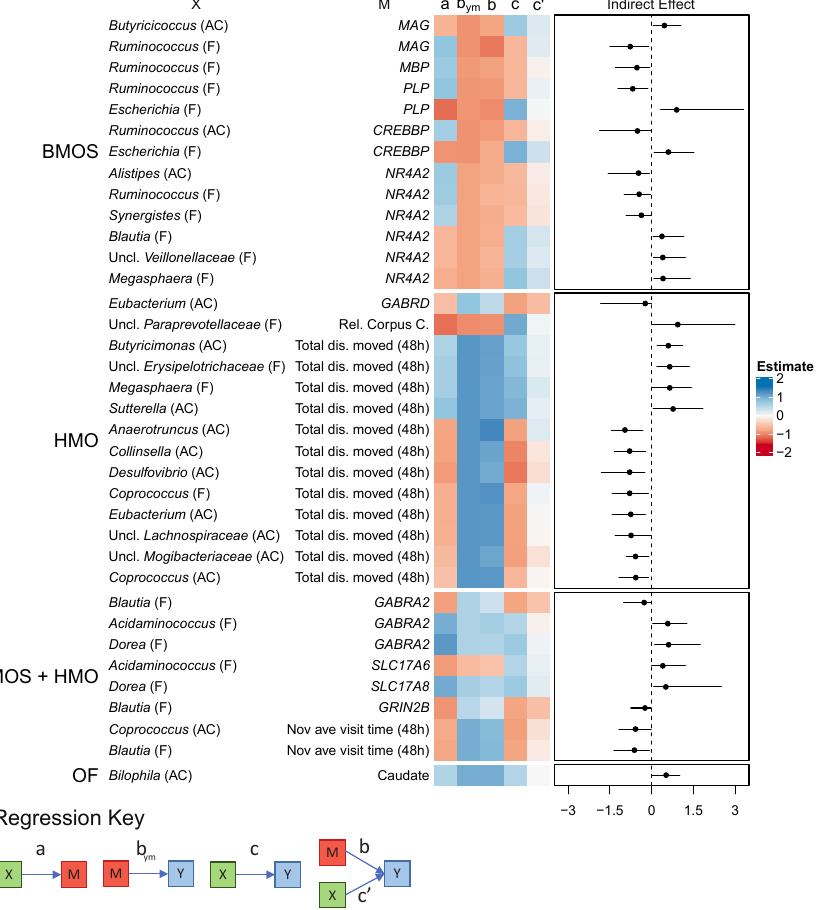
Figure 4. Heatmaps demonstrating the relationships between predictor (X), mediating (M), and predicted variables (Y, long-term recognition memory). Only mediations whose confidence intervals of the indirect effect do not include zero are shown. The right-most box represents the estimates of the indirect effect (c-c’) bounded by its lower and upper 95% confidence intervals. Paths a, b ym , b, c, and c’ are the regression coefficients for X → M, M → Y, X → Y, and X + M → Y, respectively. Abbreviations: Uncl., unclassified; CON, control group; HMO, pigs fed human milk oligosaccharides; BMOS, pigs fed bovine milk oligosaccharides; BMOS + HMO, pigs fed both human and bovine milk oligosaccharides; OF, pigs feds oligofructose; OF + 2 (cid:48) -FL, pigs fed oligofructose and 2 (cid:48)